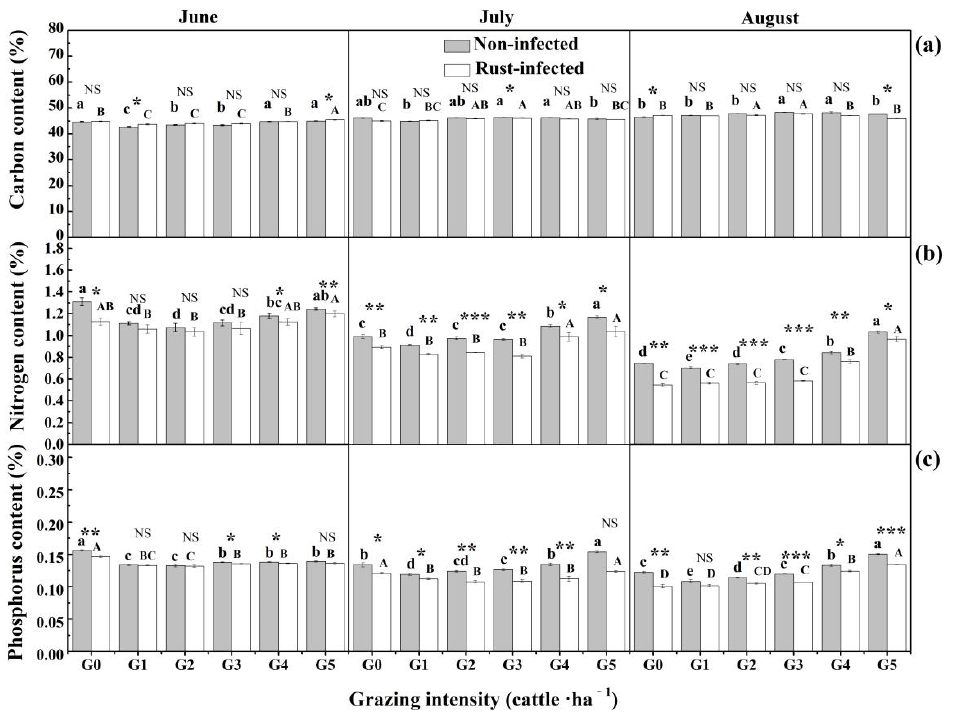
Figure 3. Influence of grazing intensity on the carbon ( a ), nitrogen ( b ) and phosphorus contents (%) ( c ) of non-infected and rust-infected Leymus chinensis from June to August based on the 2-year (2015 and 2016) average (error bars denote standard errors). Different lower-case and upper-case indicate significant differences among grazing intensities. The asterisk (*) indicates significant differences between non-infected and rust-infected plants (***, p < 0.001; **, p < 0.01; *, p < 0.05; NS, p > 0.05).